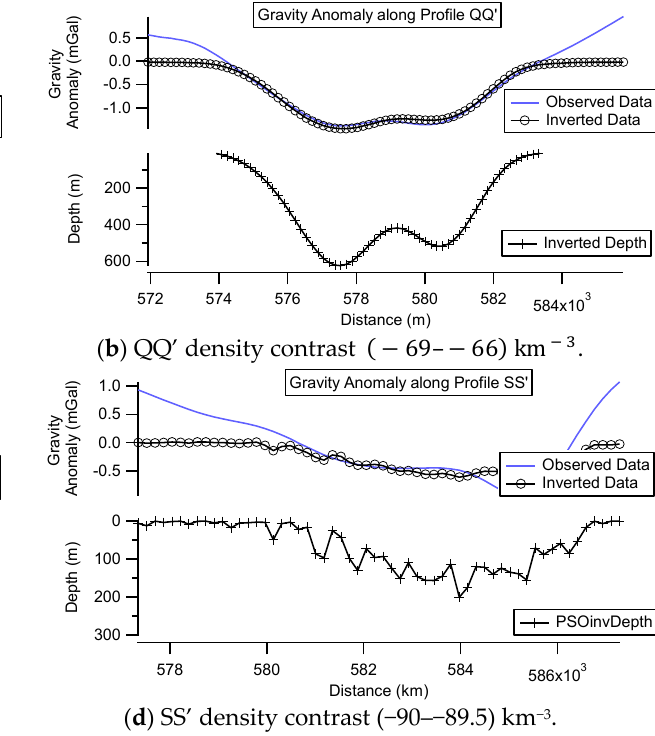
( d ) SS’ density contrast ( − 90– − 89.5) km − 3 .